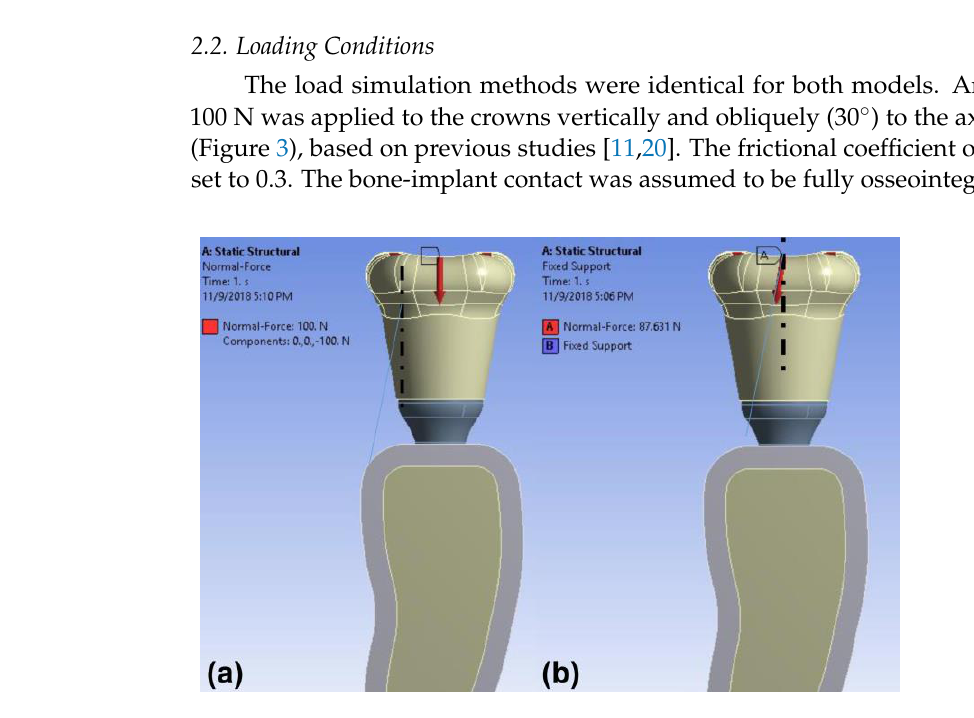
Figure 3. Schematic illustration of the loading conditions: ( a ) vertical and ( b ) oblique (30°) load.